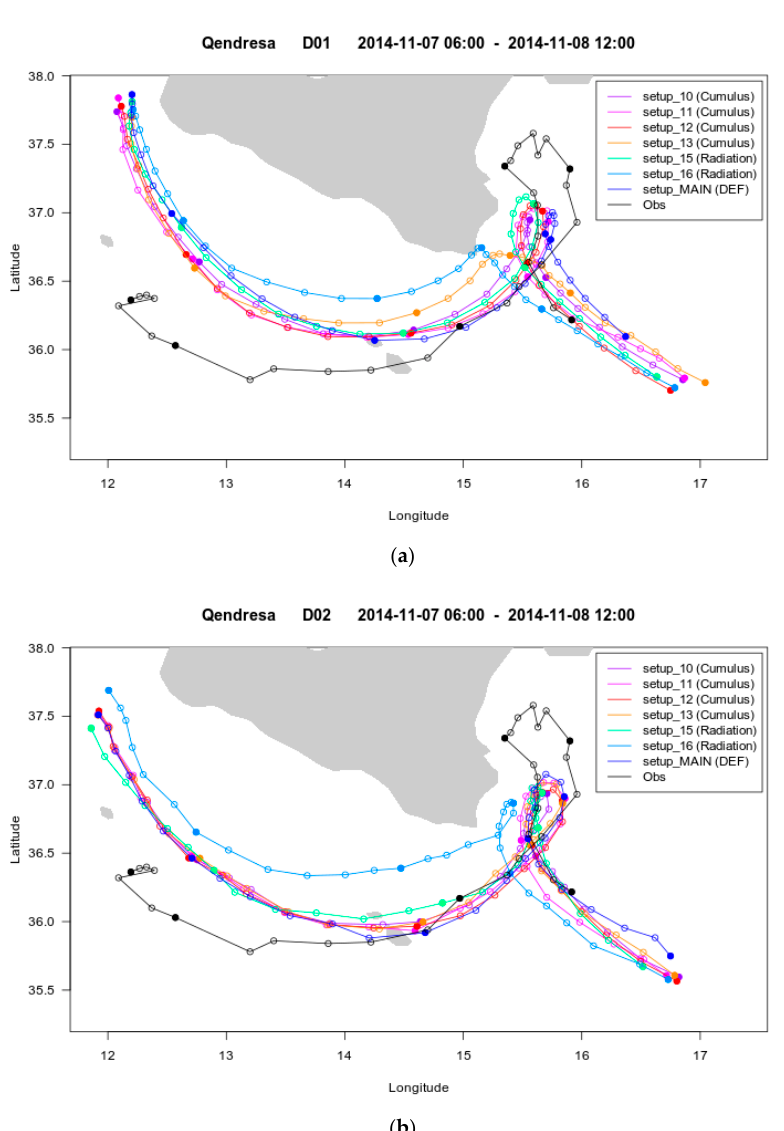
Figure 12. Trajectories of the TLC from 7 November at 06:00 UTC to 8 November at 12:00 UTC (depicted hourly) as predicted from the model CU / RAD experiments in the low ( a ) and high ( b ) resolution domain. The “combined” track (black line) and control run (setup-MAIN - blue line) are also shown. The position of the low-pressure center is denoted with solid dots every six hours, i.e., at 06:00, 12:00, 18:00 UTC November 7, and at 00:00, 06:00, 12:00 UTC November 8th, and with open dots in all other